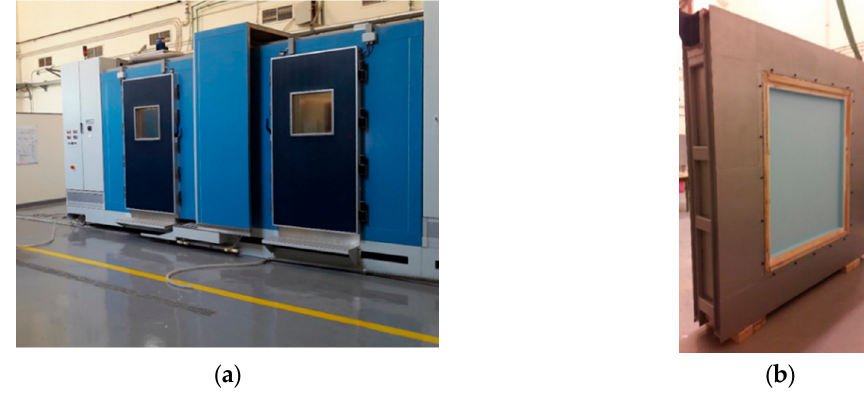
( b ) Figure 2. Metered area of the test specimen: ( a ) warm side (ID); ( b ) cold side (OD). 2.2. Experimental Design The test was performed on three wall systems with lengths of 149 cm × 124 cm and thicknesses as follows: i)